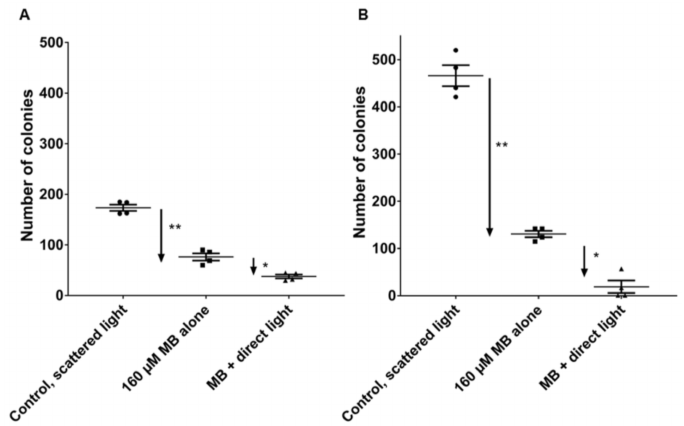
Figure 4. Clonogenic survival of SCC-25 ( A ) and Detroit 562 ( B ) cells after laser and MB treatment. After completion of treatments, 2000 cells/treatment were seeded in 75cm 2 culture dishes in 15 mL serum-supplemented culture medium for 2 weeks followed by counting the Gentian Violet-stained visible colonies (approximately 50 cells in each colony). In both SCC-25 ( A ) and Detroit 562 cells ( B ) MB significantly reduced (**: p < 0.01 by Mann-Whitney test) the number of growing colonies compared to the controls, and MB + laser further significantly (*: p < 0.05 by Mann-Whitney test) reduced the number of growing colonies compared to the only MB treated cells, n = 4; four biological